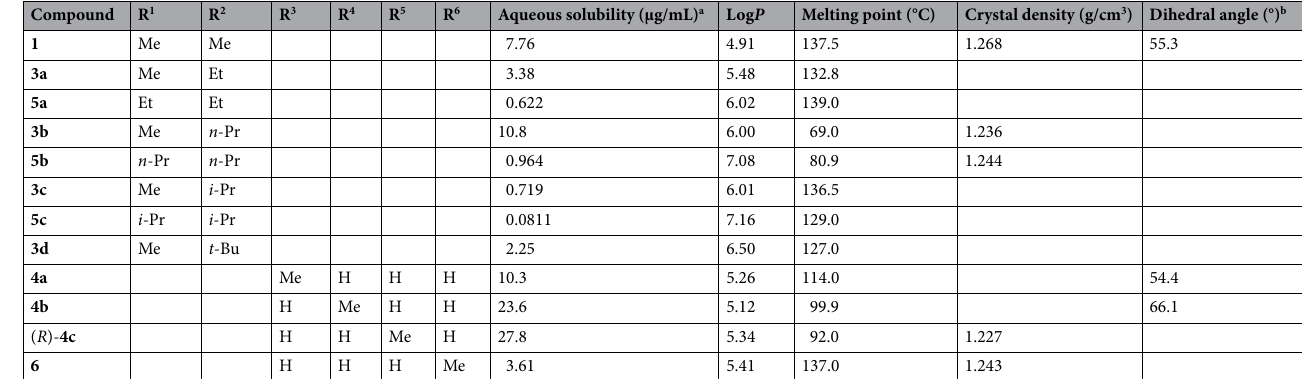
Table 1. Physicochemical properties of cyclofenil analogs. a Solubility in a mixture of 0.067 M phosphate buffer (pH 6.8) and EtOH (6:4). b The most stable forms were estimated with